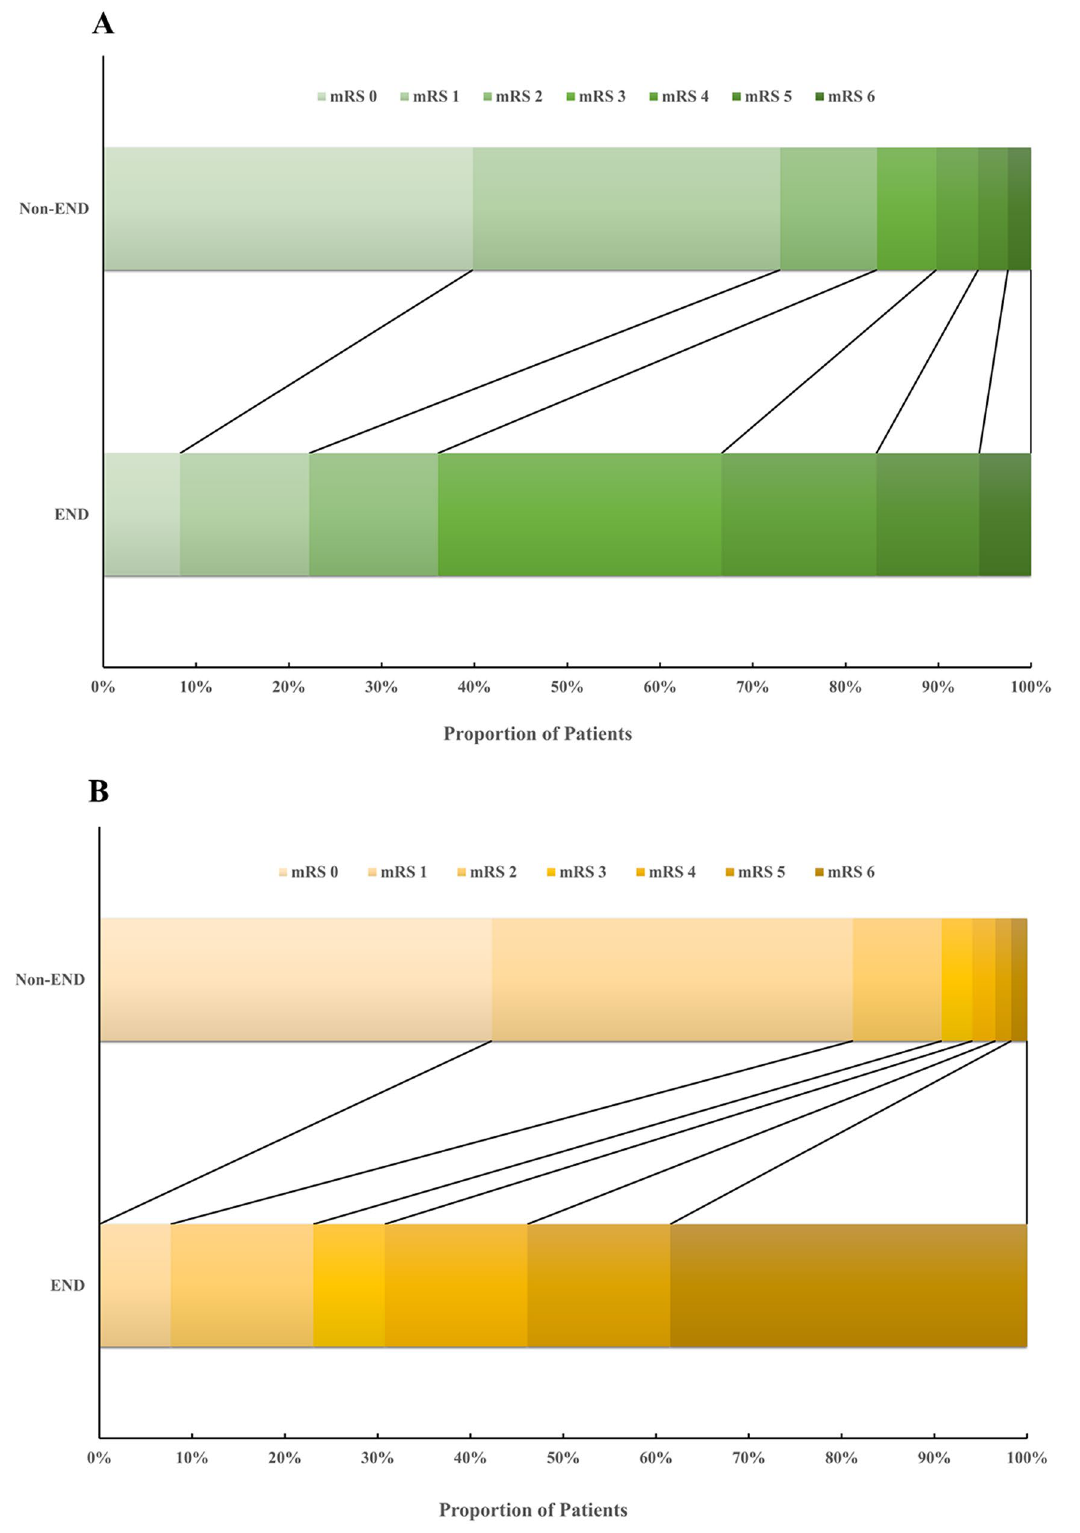
Figure 3. The 90-day mRS distribution in thrombolytic patients with Non-END vs END. ( A ) 90-day mRS distribution in anterior circulation stroke. ( B ) 90-day mRS distribution in posterior circulation stroke. END early neurological deterioration, mRS modified ranking